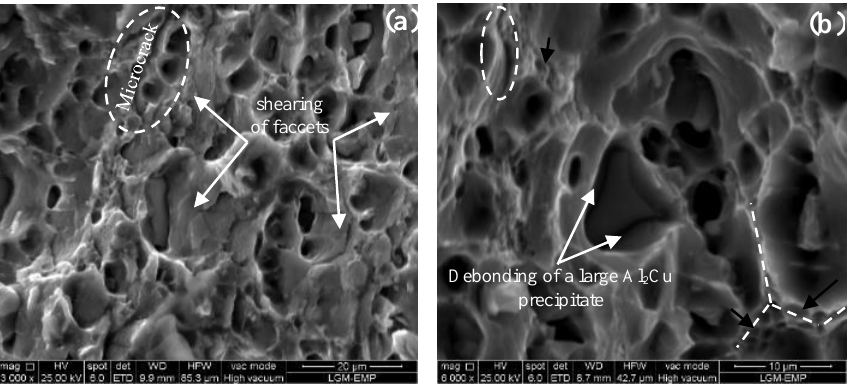
Fig. 9. Fractography at higher Magnification indicates the mechanism of